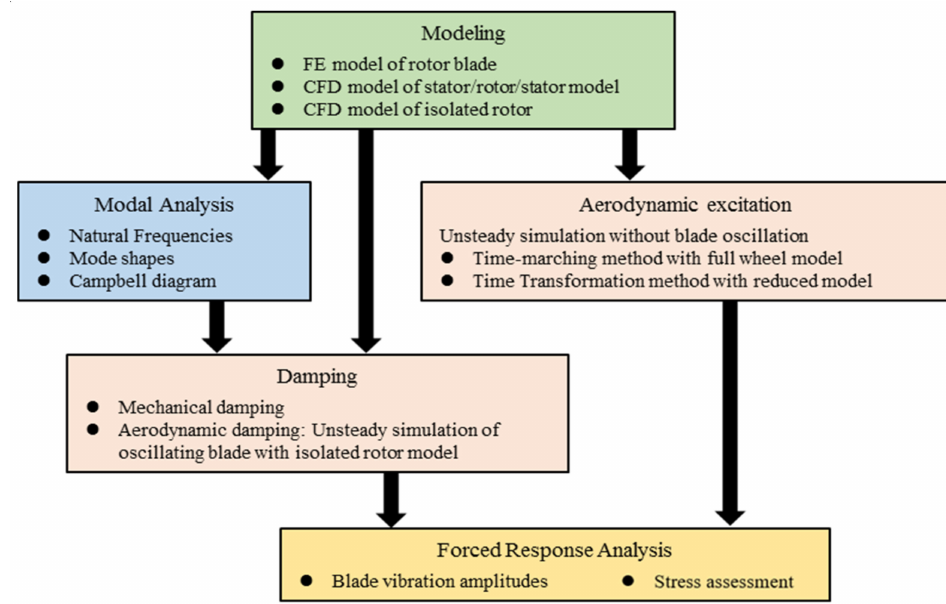
Figure 1. Flow chart of the investigation